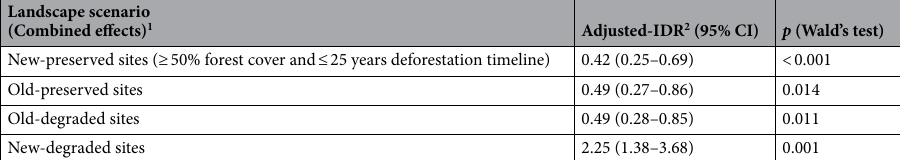
Table 3. Poisson generalized linear models of mean numbers of infected anophelines as a function of the combined effects of accumulated deforestation and the deforestation timeline adjusted by control variables. 1 Preserved and new sites (14/41 = 34.2%), preserved and old sites (8/41 = 19.5%), degraded and new sites (3/41 = 7.3%), and degraded and old sites (16/41 = 39%). 2 The adjusted incidence density ratio of infected anophelines between the new-degraded landscape scenario and the three other landscape scenarios adjusted by the number of collectors (3 or 4) and the period of collection (12 h or 6 h).